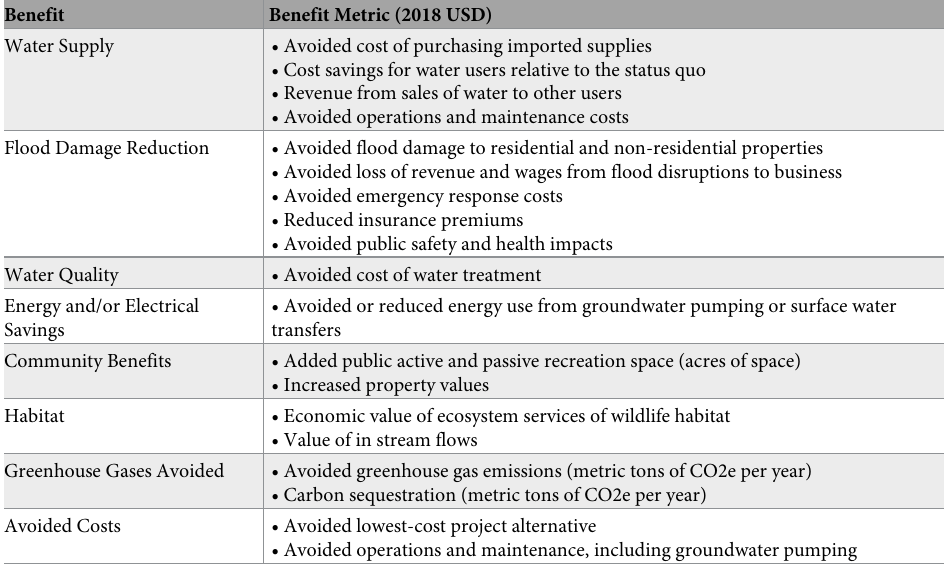
Table 4. Benefit categories and selected metrics reported in